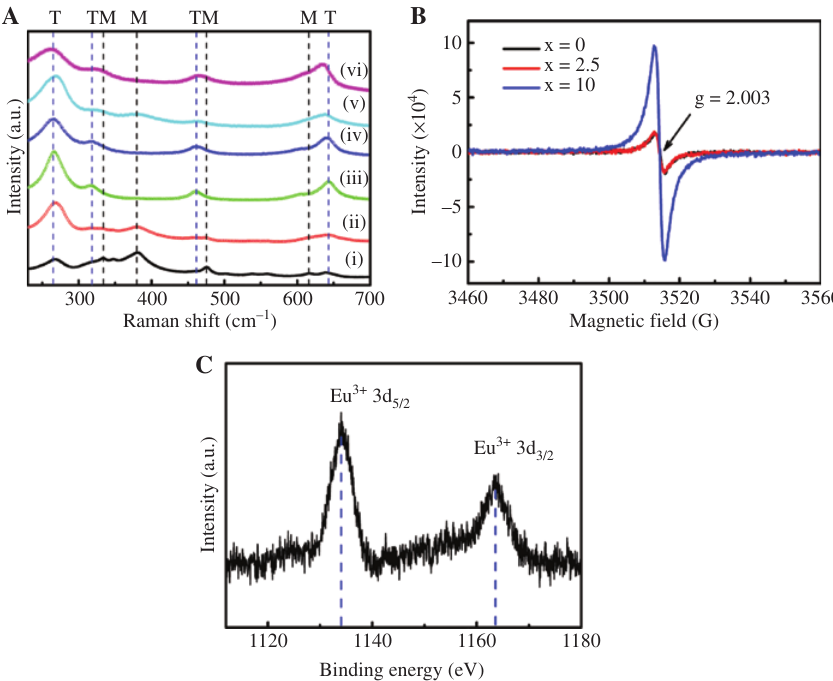
Figure 2: The phase transformation, the evolution of oxygen vacancy and the valence state of Eu ions. (A) Raman spectra of ZrO : x Eu 3 + : (i) 0%, (ii) 0.5%, (iii) 2.5%, (iv) 5%, (v) 7.5%, and (vi) 10%. (B) Room-temperature EPR spectra of the samples 2 with different doping concentrations. (C) High-resolution XPS spectrum for Eu element in ZrO